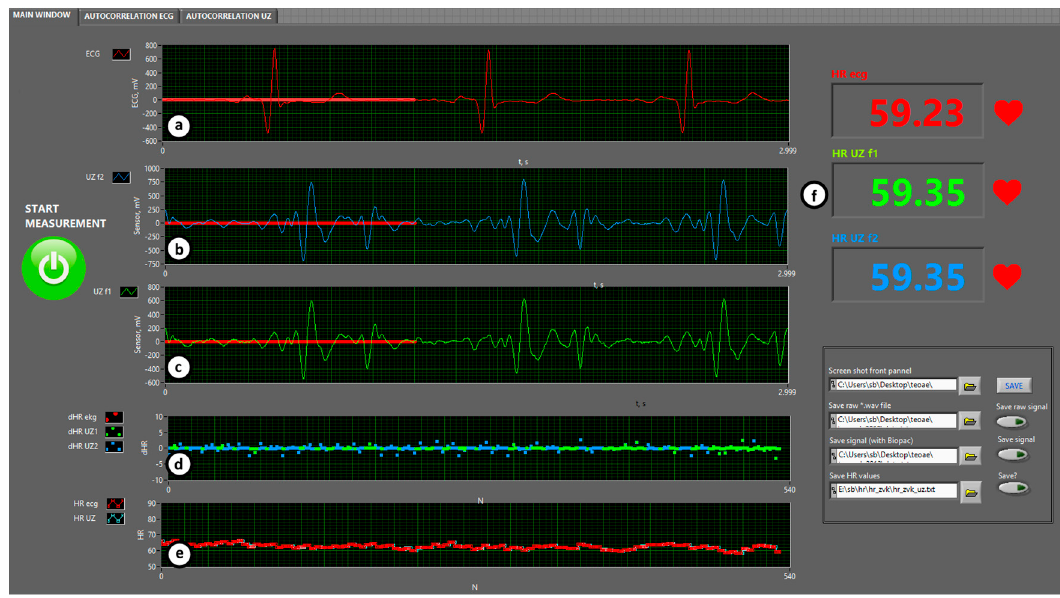
Figure 2. Front panel of the dedicated LabVIEW user interface: ( a ) reference III-Lead ECG signal; ( b ) processed ultrasound signal at f 1 = 40 kHz; ( c ) processed ultrasound signal at f 2 = 39 kHz. Note that US signals are delayed compared to ECG signal for about 200 ms because of the type and place of measurement; ( d ) measuring error, i.e., difference between the reference signal and experimental method signal instantaneous HR displayed on a diagram; ( e ) diagram of instantaneous HR of the two methods in question and ( f ) numerical display of instantaneous HR of all three signals.